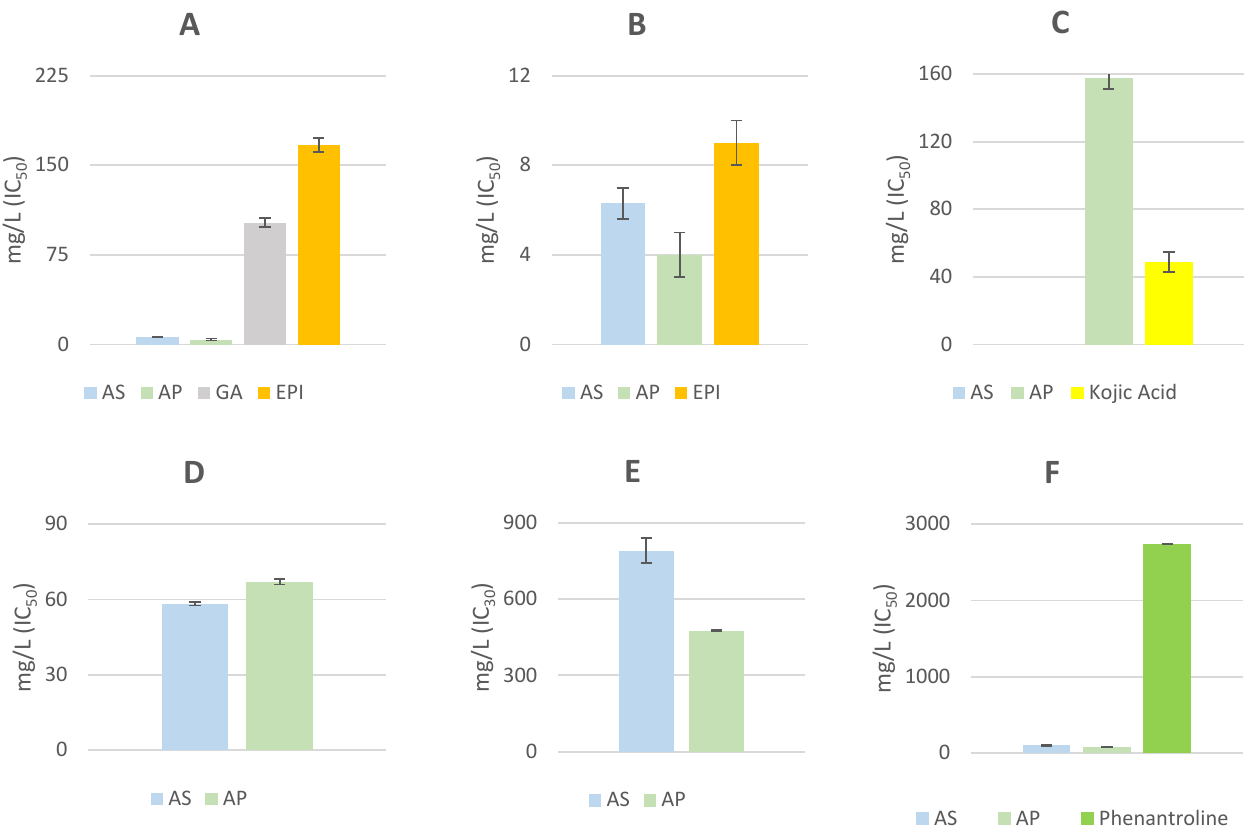
Figure 3. Inhibitory capacity analysis of ( A ) hyaluronidase, ( B ) xanthine oxidase, ( C ) tyrosinase, ( D ) acetylcholinesterase, ( E ) elastase and ( F ) collagenase, by avocado seed (AS) and peel (AP). Data are means ± standard deviation (n = 3). Results are expressed as IC 50 (mg/L). EPI (epicatechin), kojic acid and phenanthroline were used as positive controls, in addition to physostigmine and elastatinal for acetylcholinesterase and elastase,